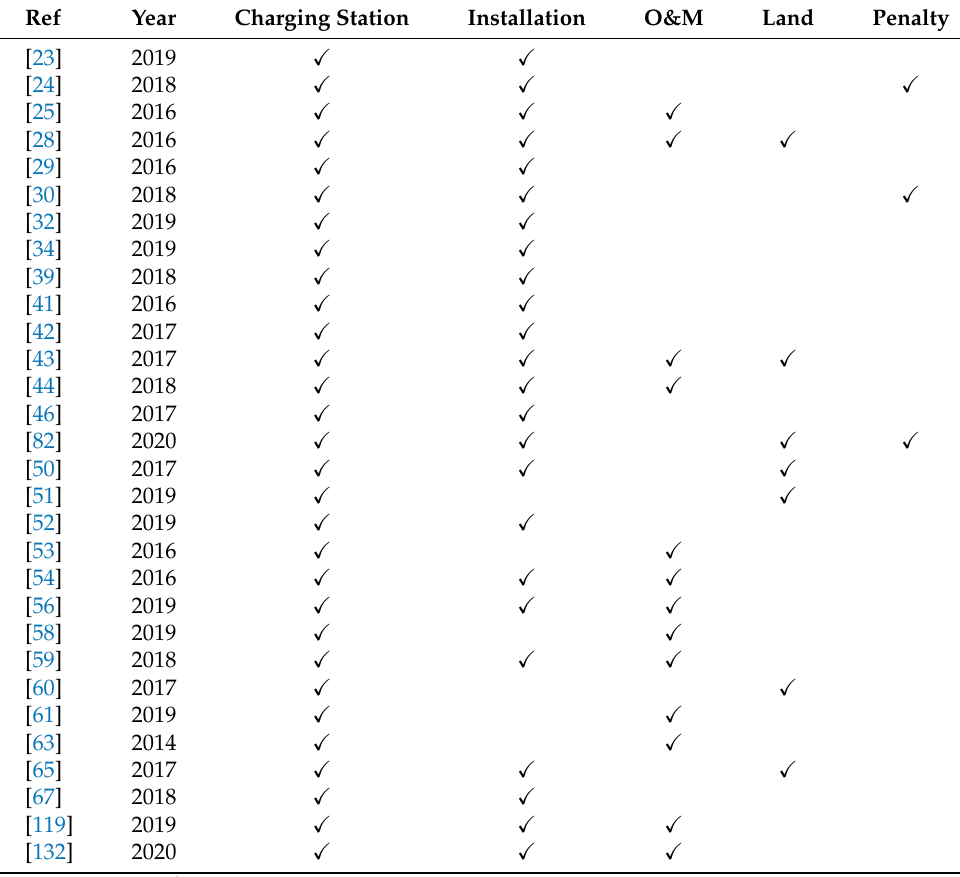
Table 4. Planning: service provider